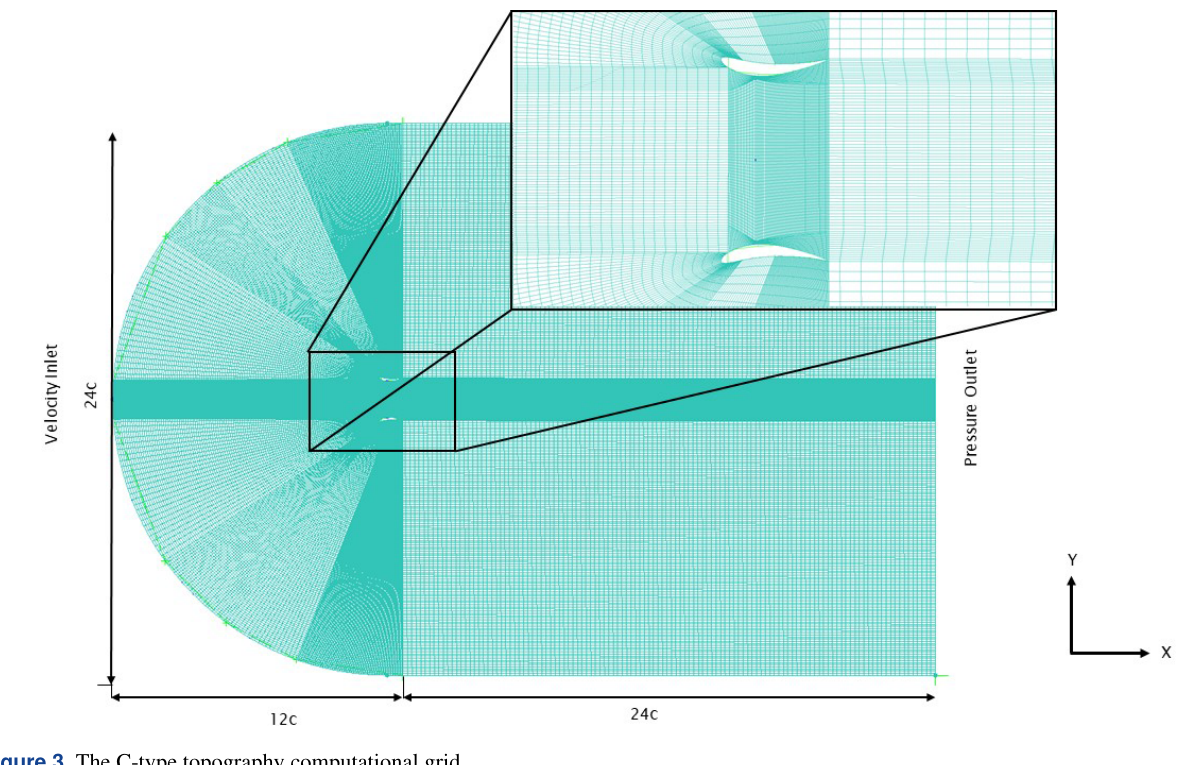
Figure 3. The C-type topography computational grid.